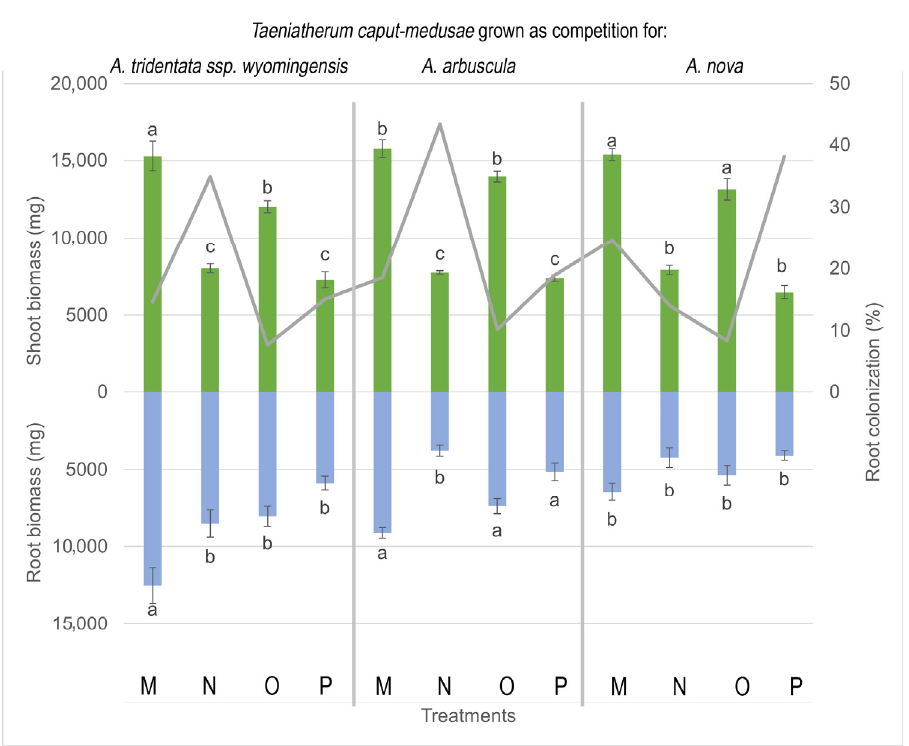
Figure 4. Shoot and root biomass (bars) and root colonization (lines) ±SE (error bars) of Taeniatherum caput-medusae grown in competition with 3 species of Artemisia under different combinations of treatments (soil, moisture, and AMF inoculation) for 21 weeks. Different letters above and below bars indicate significant differences among treatments (Tukey’s HSD). All treatments have commercial AMF inoculum, sham treatments not shown. Treatments: (M) high moisture, autoclaved soil; (N) high moisture, field soil; (O) low moisture, autoclaved soil; (P) low moisture, field soil.